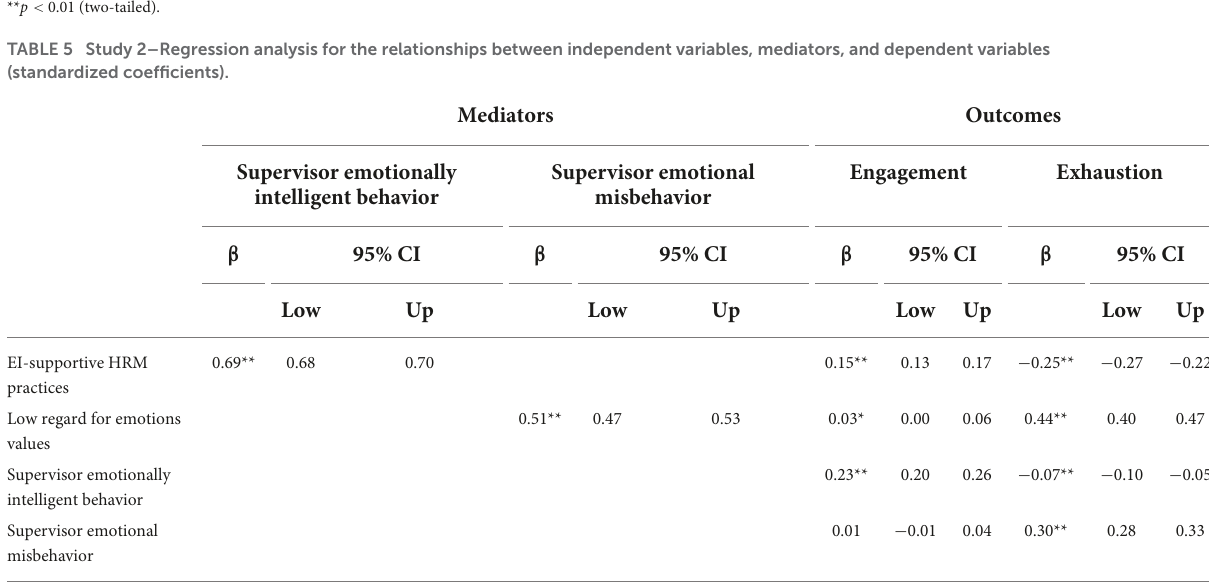
TABLE 5 Study 2–Regression analysis for the relationships between independent variables, mediators, and dependent variables (standardized coefficients).